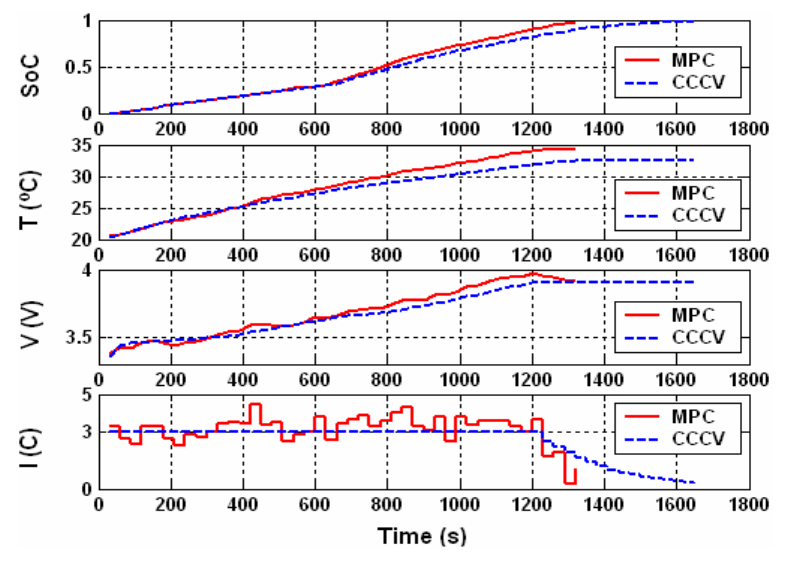
Figure 9. Curves during CCCV and MPC charging processes using modified 3 C